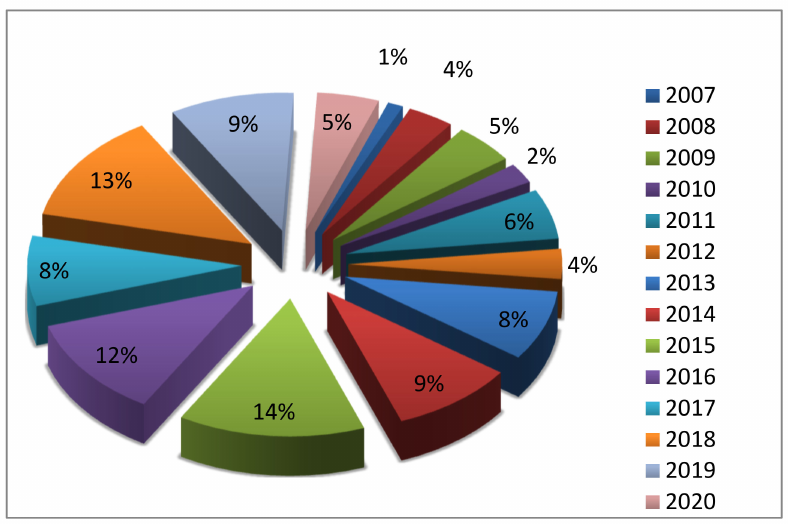
Figure 7. Distribution per annum of presented papers applicable to the HS and FL (2007~22 August